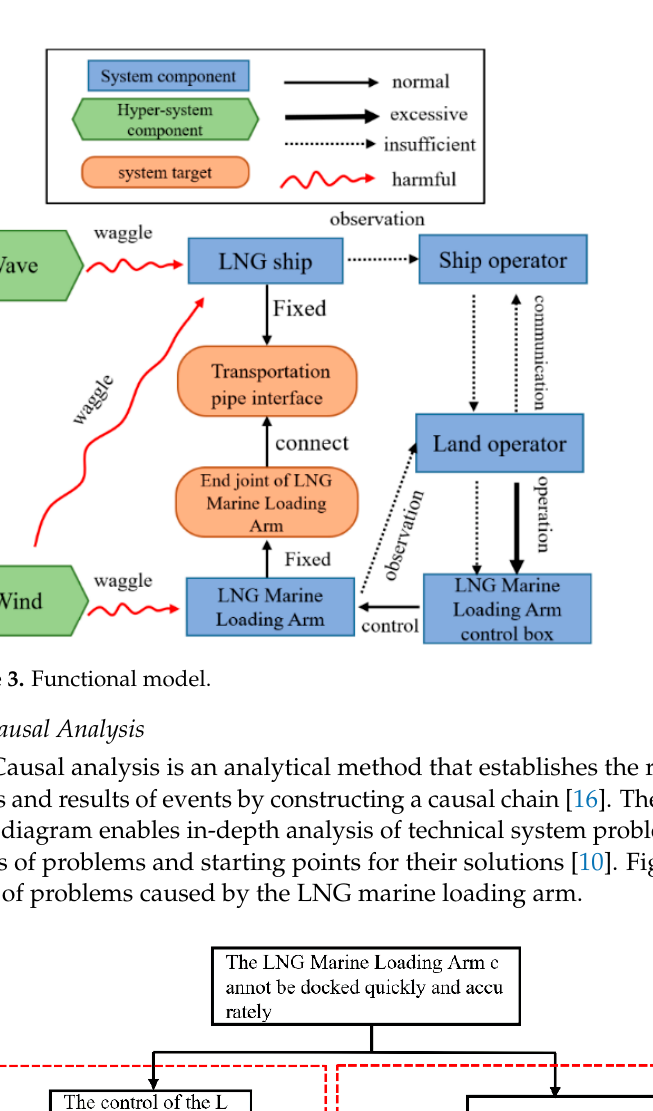
Figure 2. Working schematic diagram of LNG marine loading arm docking with LNG ship. 1—LNG marine loading arm control box; 2—LNG marine loading arm; 3—end joint of the LNG marine load- ing arm; 4—land operator; 5—wave; 6—LNG ship; 7—transportation pipe interface; 8—ship opera- tor; 9—wind.